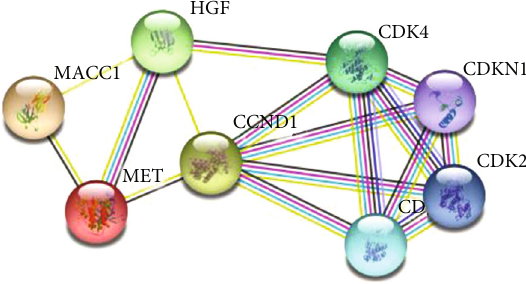
Figure 6: Connection diagram of MACC1, c-Met, and cyclin